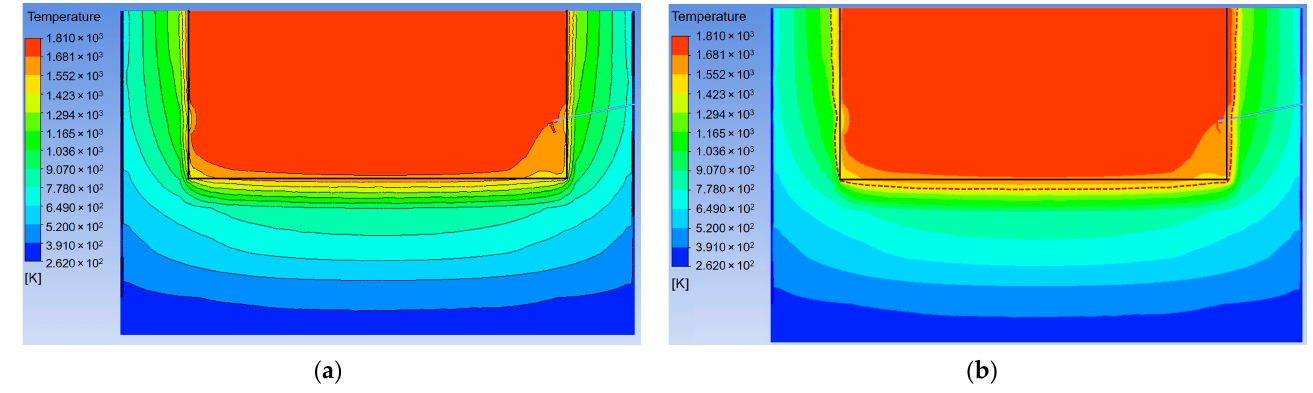
Figure 6. ( a ) Hearth temperature field in the xz cross section; ( b ) position of 1423 K